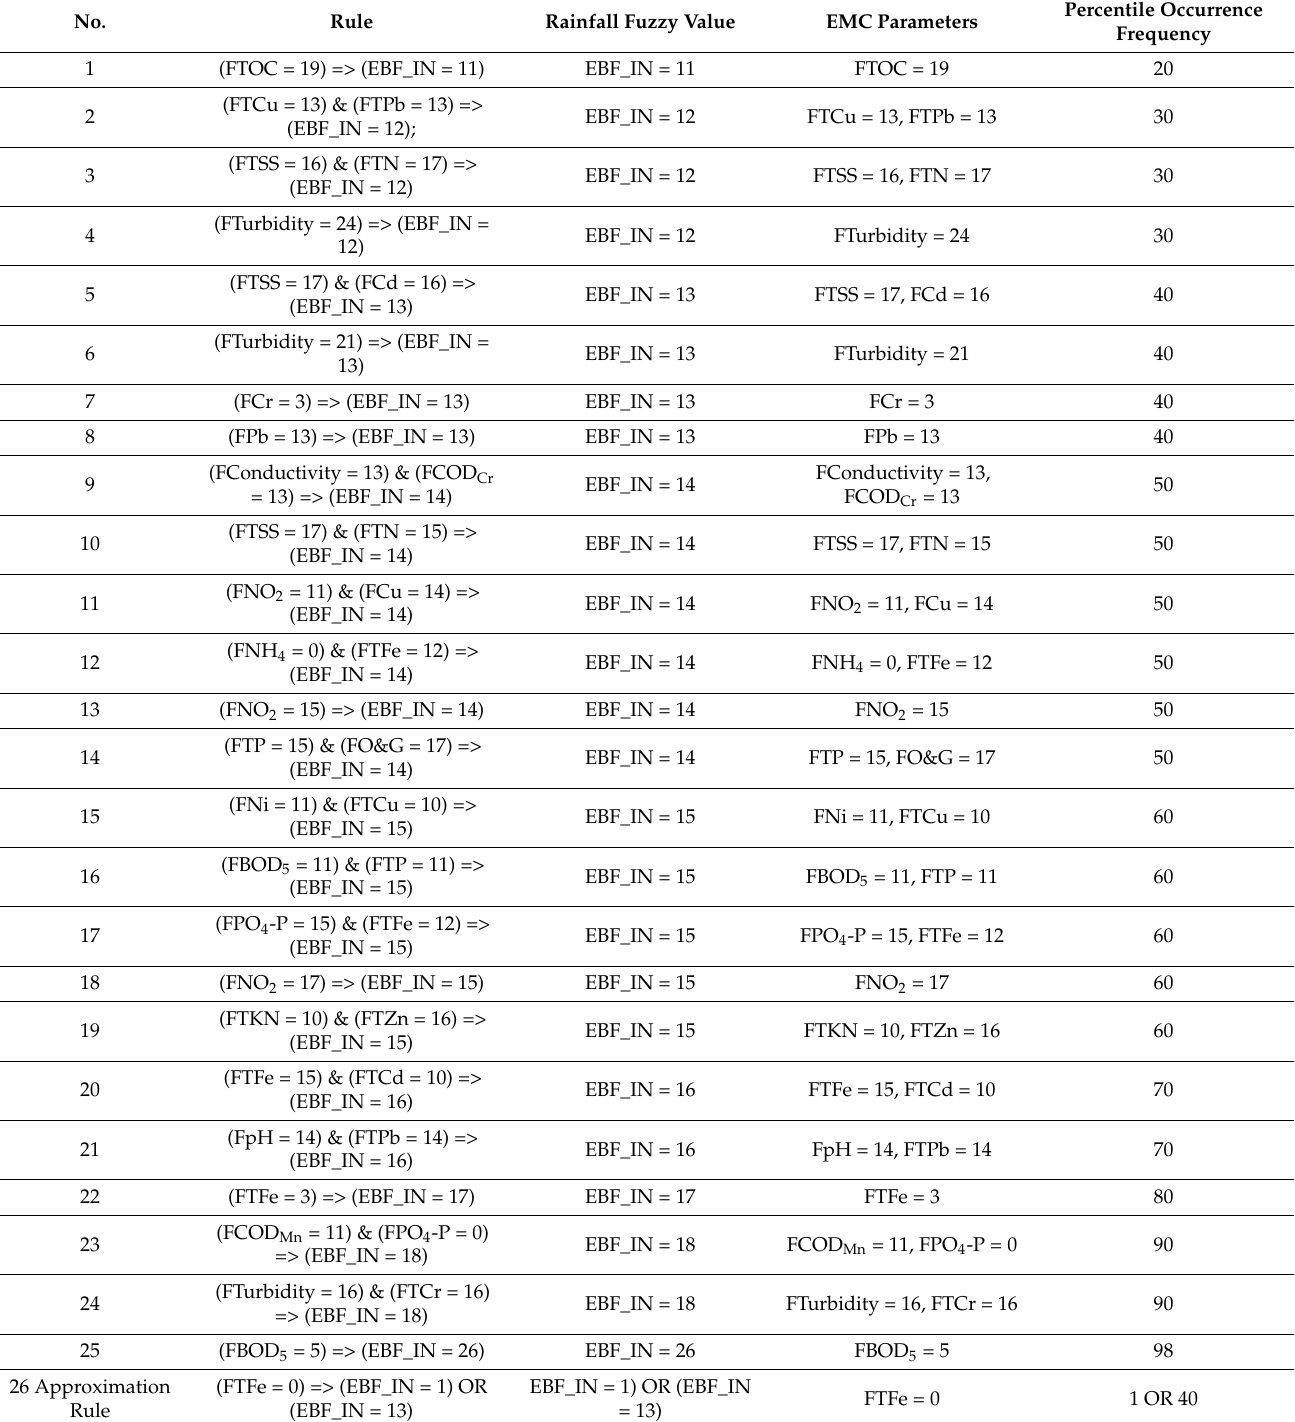
Table 6. EBF IN fuzzified values rules